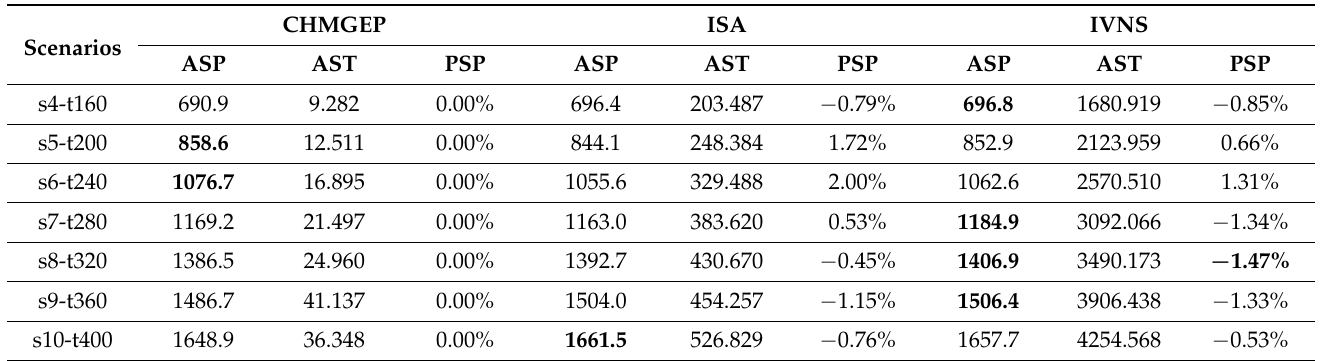
Table 11. The comparison of metaheuristic algorithms on scheduling profit.